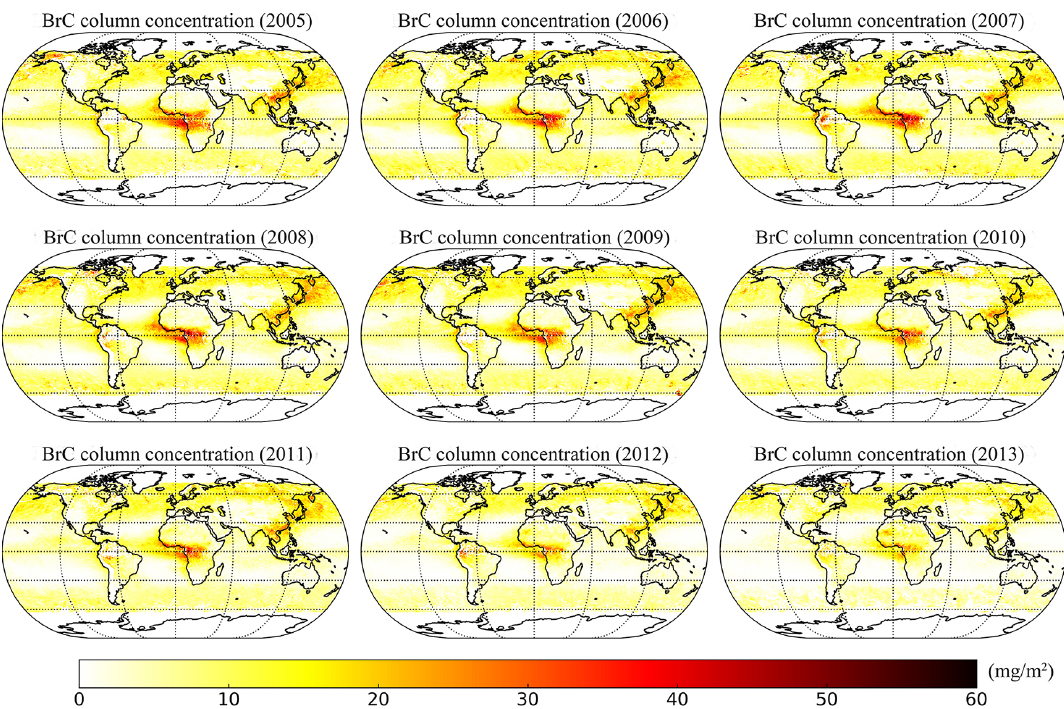
Figure 7. Yearly mean of BrC column mass concentration (mgm − 2 ) derived from POLDER-3 observations using the GRASP/Component approach for the period from March 2005 to October